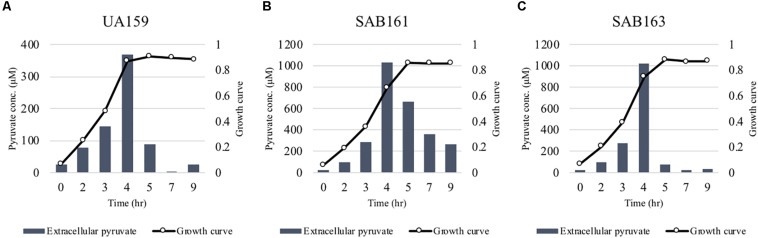
Measurement of extracellular pyruvate during growth of the lrg derivative strains. The strains, including S. mutans UA159 (WT, A), SAB161 (lrgAB-overexpressing, B), and SAB163 (lytST-overexpressing, C) were cultivated in FMC medium supplemented by 11 mM glucose. For time course measurements of extracellular pyruvate and growth, samples were taken at 1 or 2 h intervals (see section “Materials and Methods” for details). The concentration of pyruvate was determined using an EnzyChromTM pyruvate assay kit, and growth was measured by the optical density at 600 nm (OD600). Bars indicates the average concentration of extracellular pyruvate; solid line with circles indicates the corresponding growth curve. The results are representative of two independent experiments.